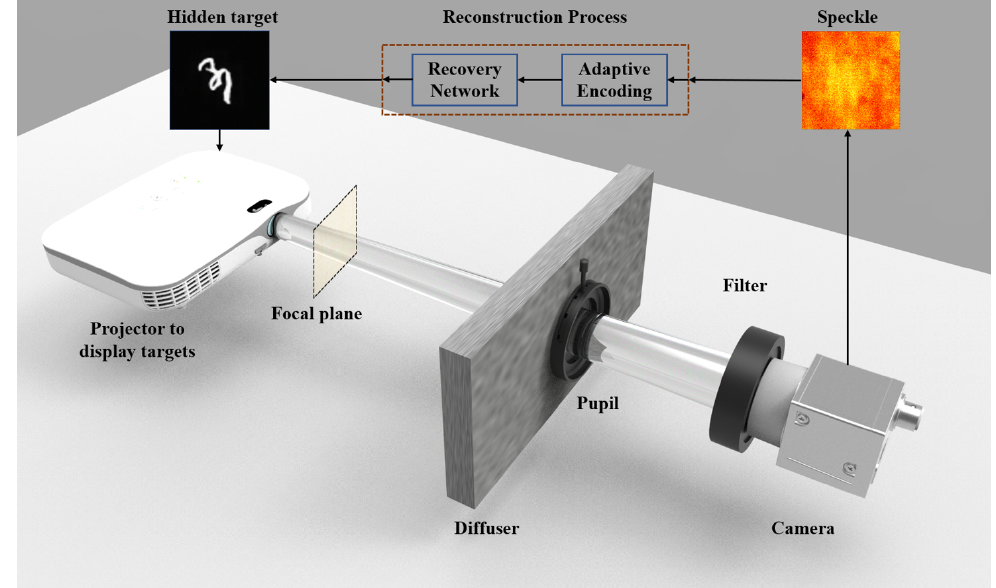
Figure 2. The optical system setup and the process of adaptive encoding and reconstruction of